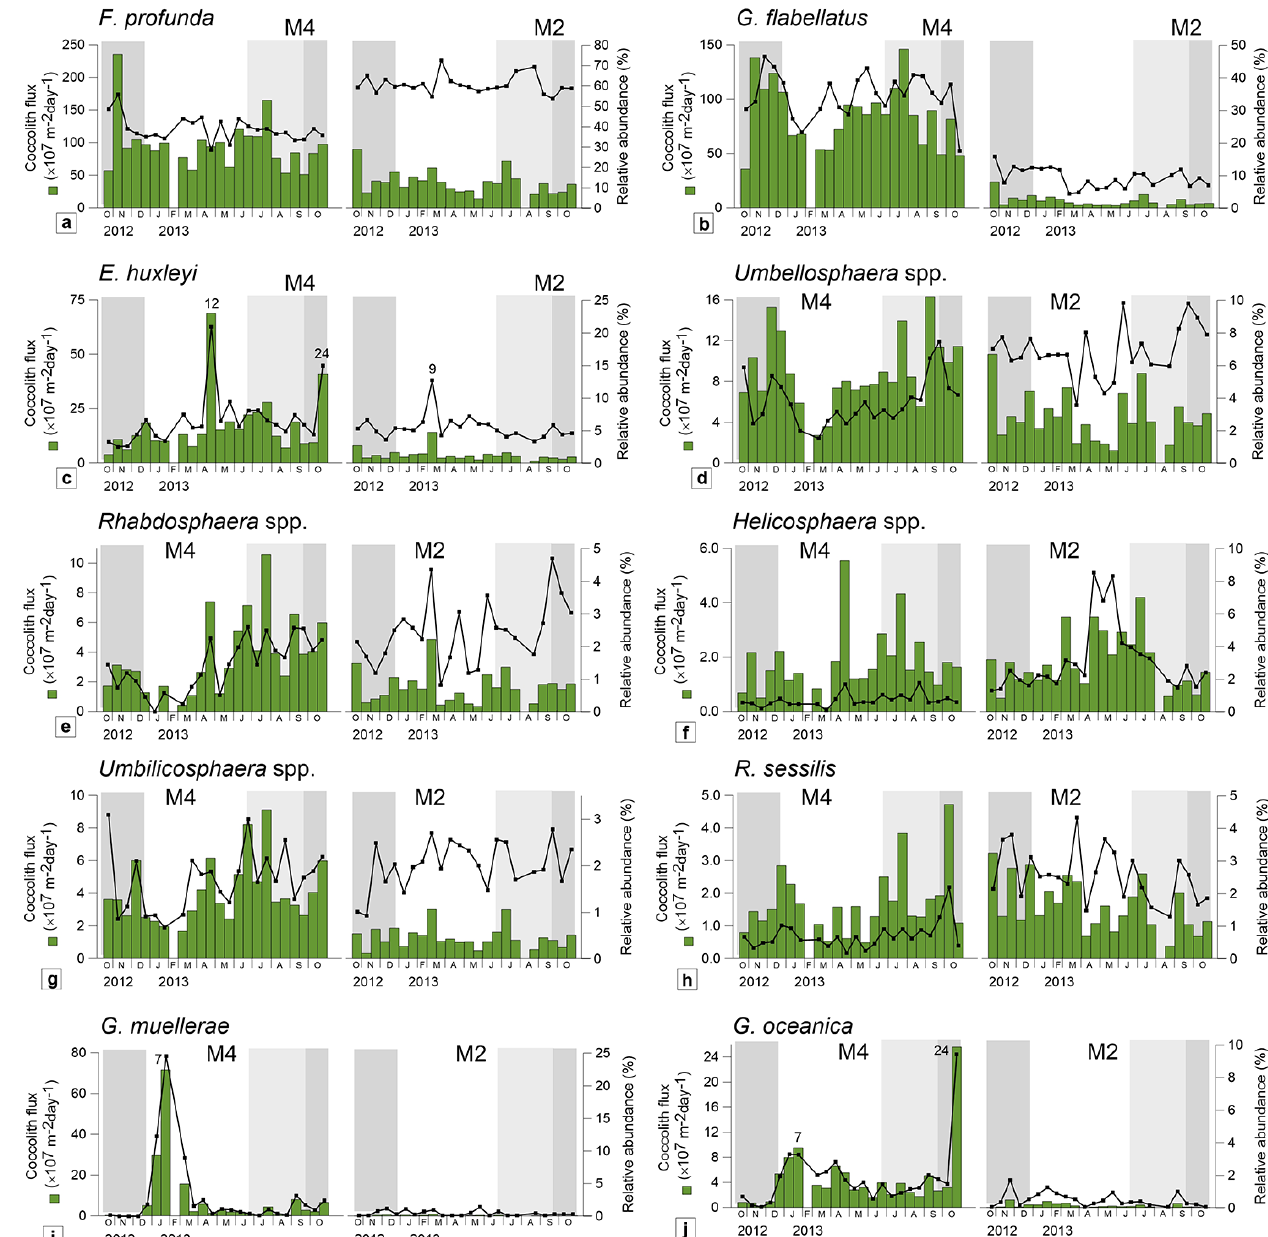
Figure 6. Coccolith export fluxes and relative abundance of the most important species at stations M4 and M2: (a) F. profunda , (b) G. flabel- latus , (c) E. huxleyi , (d) Umbellosphaera spp., (e) Rhabdosphaera spp., (f) Helicosphaera spp., (g) Umbilicosphaera spp., (h) R. sessilis , (i) G. muellerae , and (j) G. oceanica. Dark and light grey bars indicate boreal fall and summer, respectively. Numbers 7, 12, and 24 indicate the sample reference for the time intervals during which G. muellerae , E. huxleyi , and G. oceanica produced “pulse-like” maxima at station M4 (i.e. late January, middle April, and late October to early November 2013, respectively), whereas number 9 indicates the sample reference for the time interval during which enhanced fluxes of E. huxleyi occurred at station M2 (i.e. early March